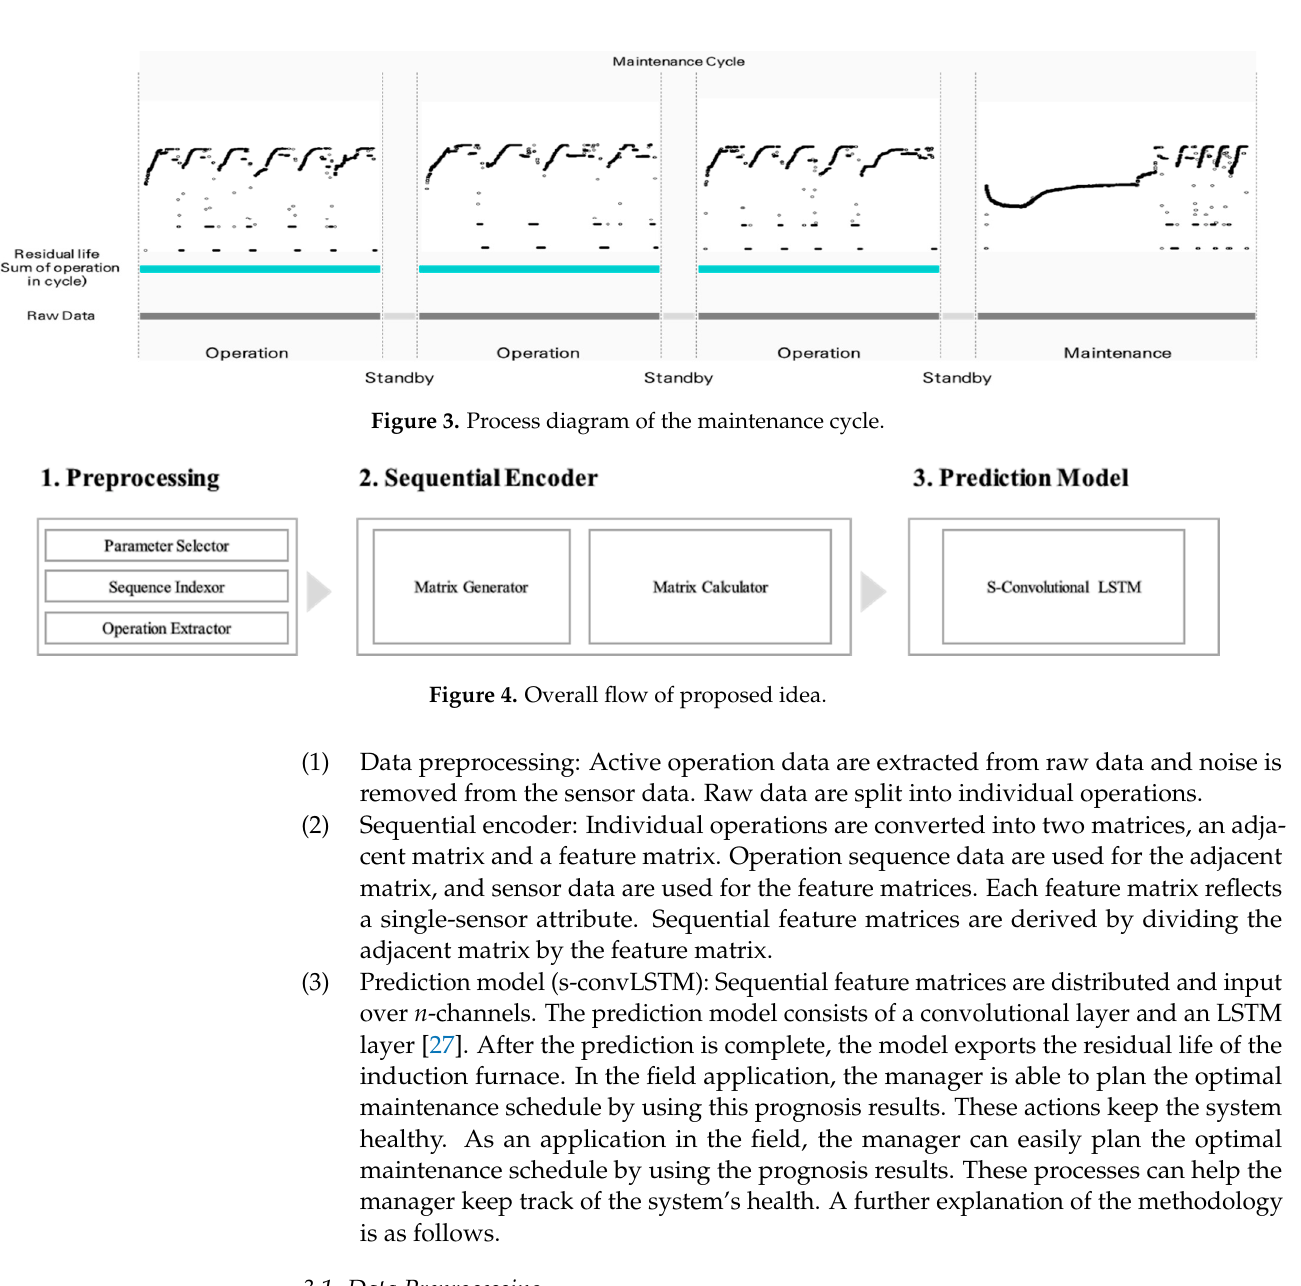
Figure 4. Overall flow of proposed idea.